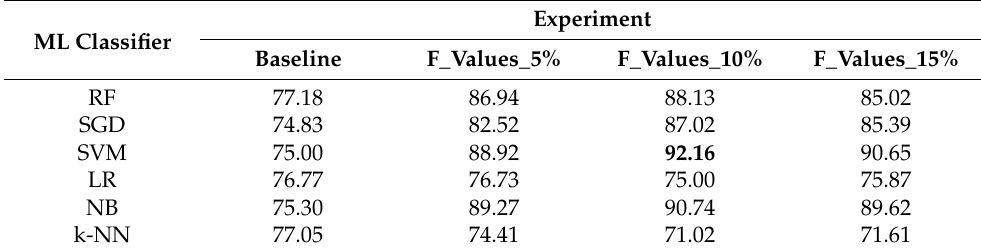
Table 11. Accuracy of different experiments with combination of UFs and